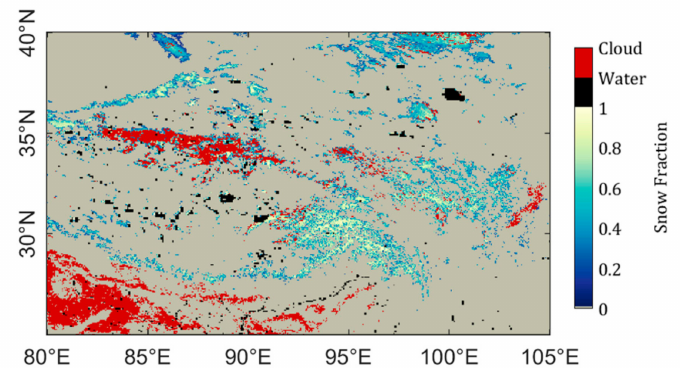
Figure 14. The Himawari–8 AHI daily fractional snow cover of the Tibetan Plateau on 17 January